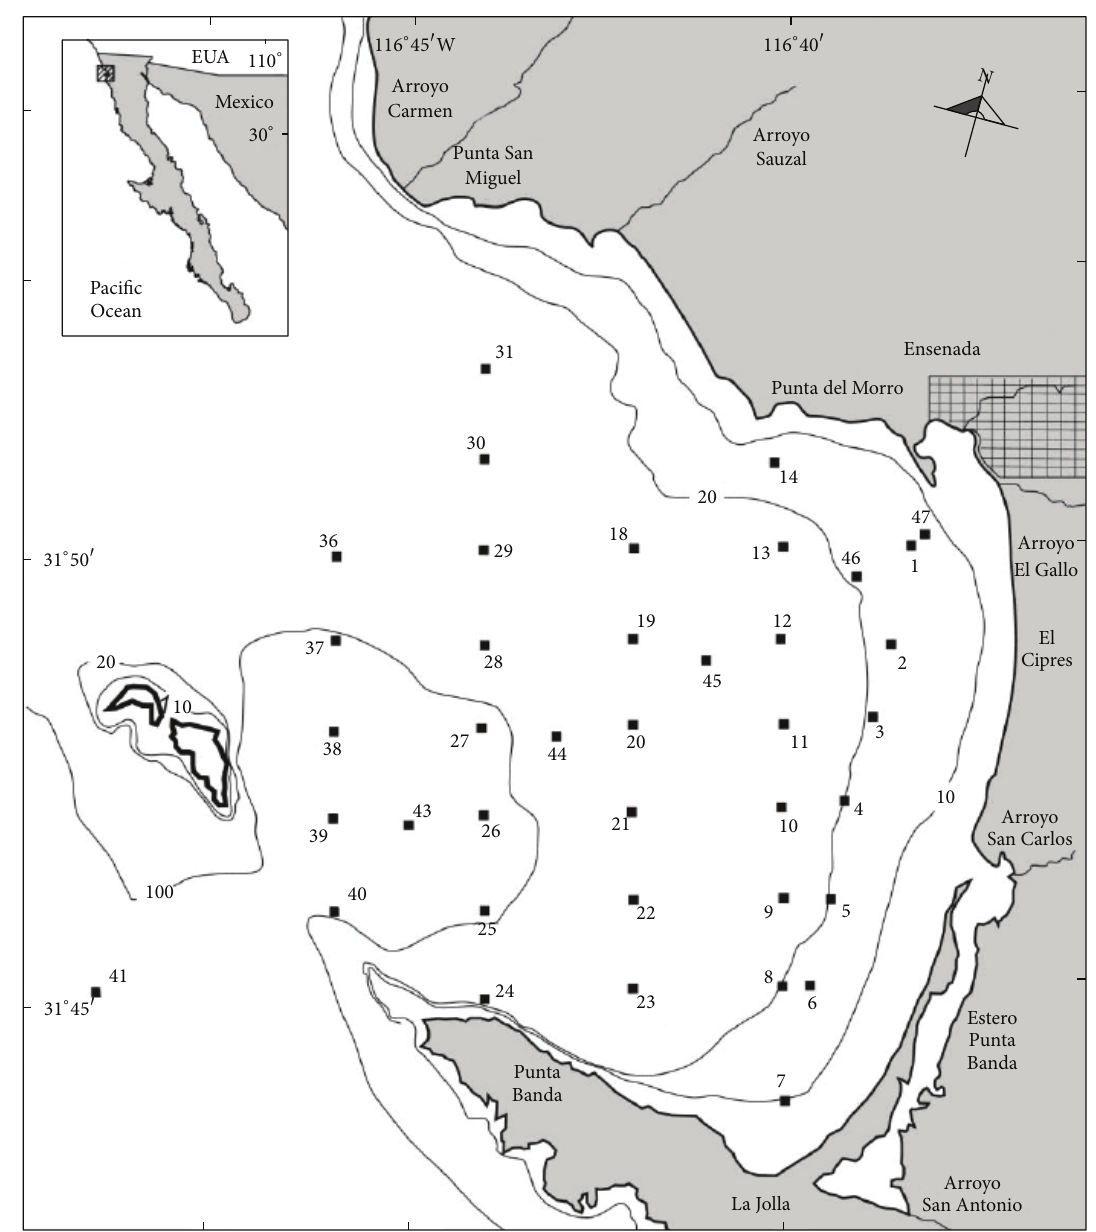
Figure 1: Study area in Todos Santos Bay, Baja California: locations of sampling